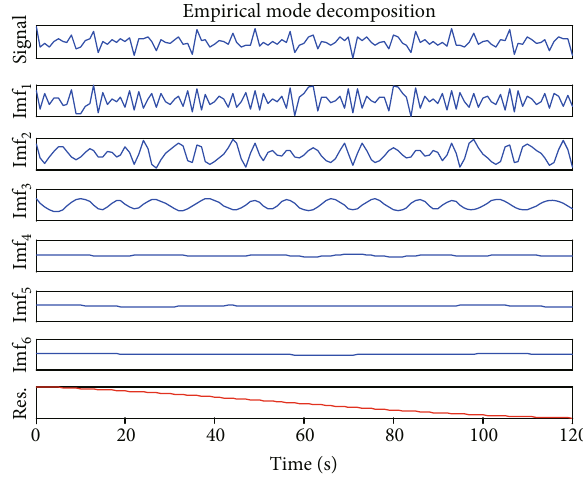
Figure 4: Results after EMD